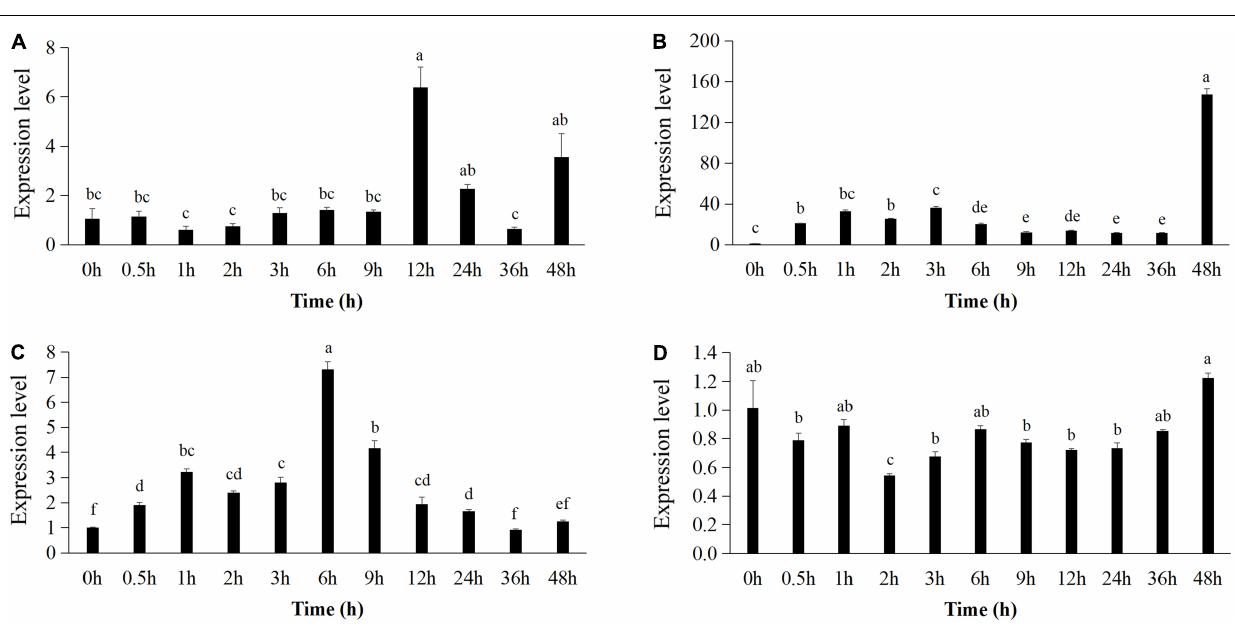
FIGURE 5 | Expression of genes related to defense responses in cucumber roots. (A–D) Expression level of pr1 (A) , pr2 (B) , lox1 (C) , and ctr1 (D) in cucumber roots treated by Bv-25 or sterile water. Different letters indicate significant differences ( p < 0.05; n = 9) between treatments according to Duncan multiple-range test following one-way